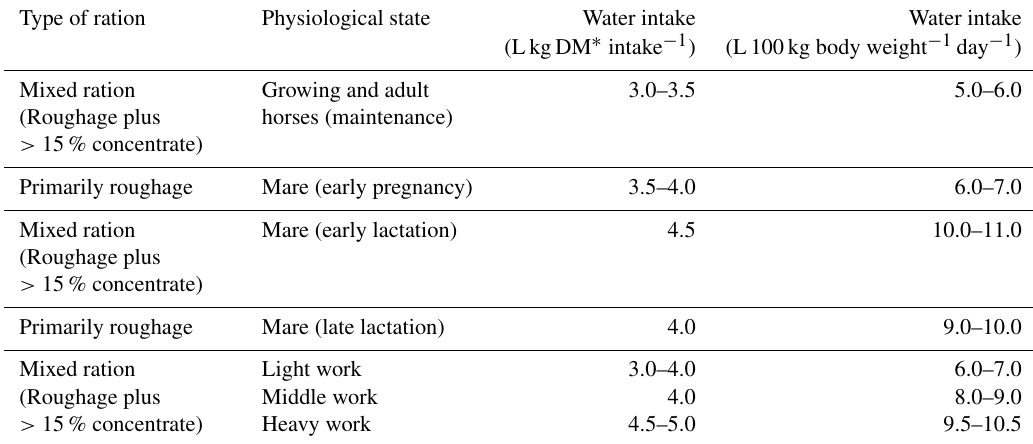
Table 8. Total water intake of horses related to dry matter and body weight at an ambient temperature of 15 ◦ C (Martin-Rosset et al., 2015).